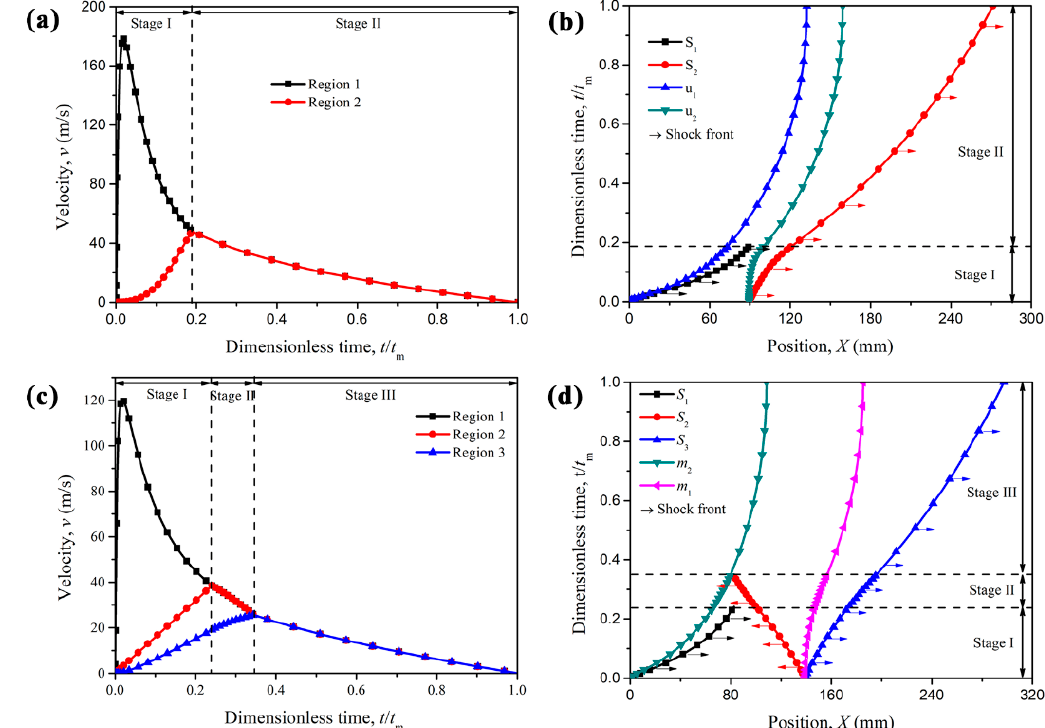
Figure 5. ( a ) Time histories of Region velocities and ( b ) the position of shock fronts for PG-U cladding ( γ = 2/3, L 2 = 91.6 mm and L = 272 mm); ( c ) time histories of Region velocities and ( d ) the position of shock fronts for NG-U cladding ( γ = − 2/3, L 2 = 140 mm and L = 298 mm).